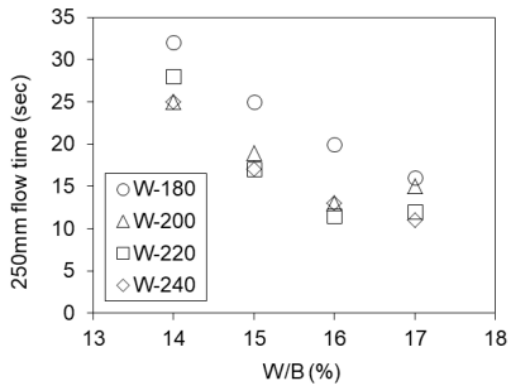
Figure 12. Relations between W/B and 250 mm flow time.